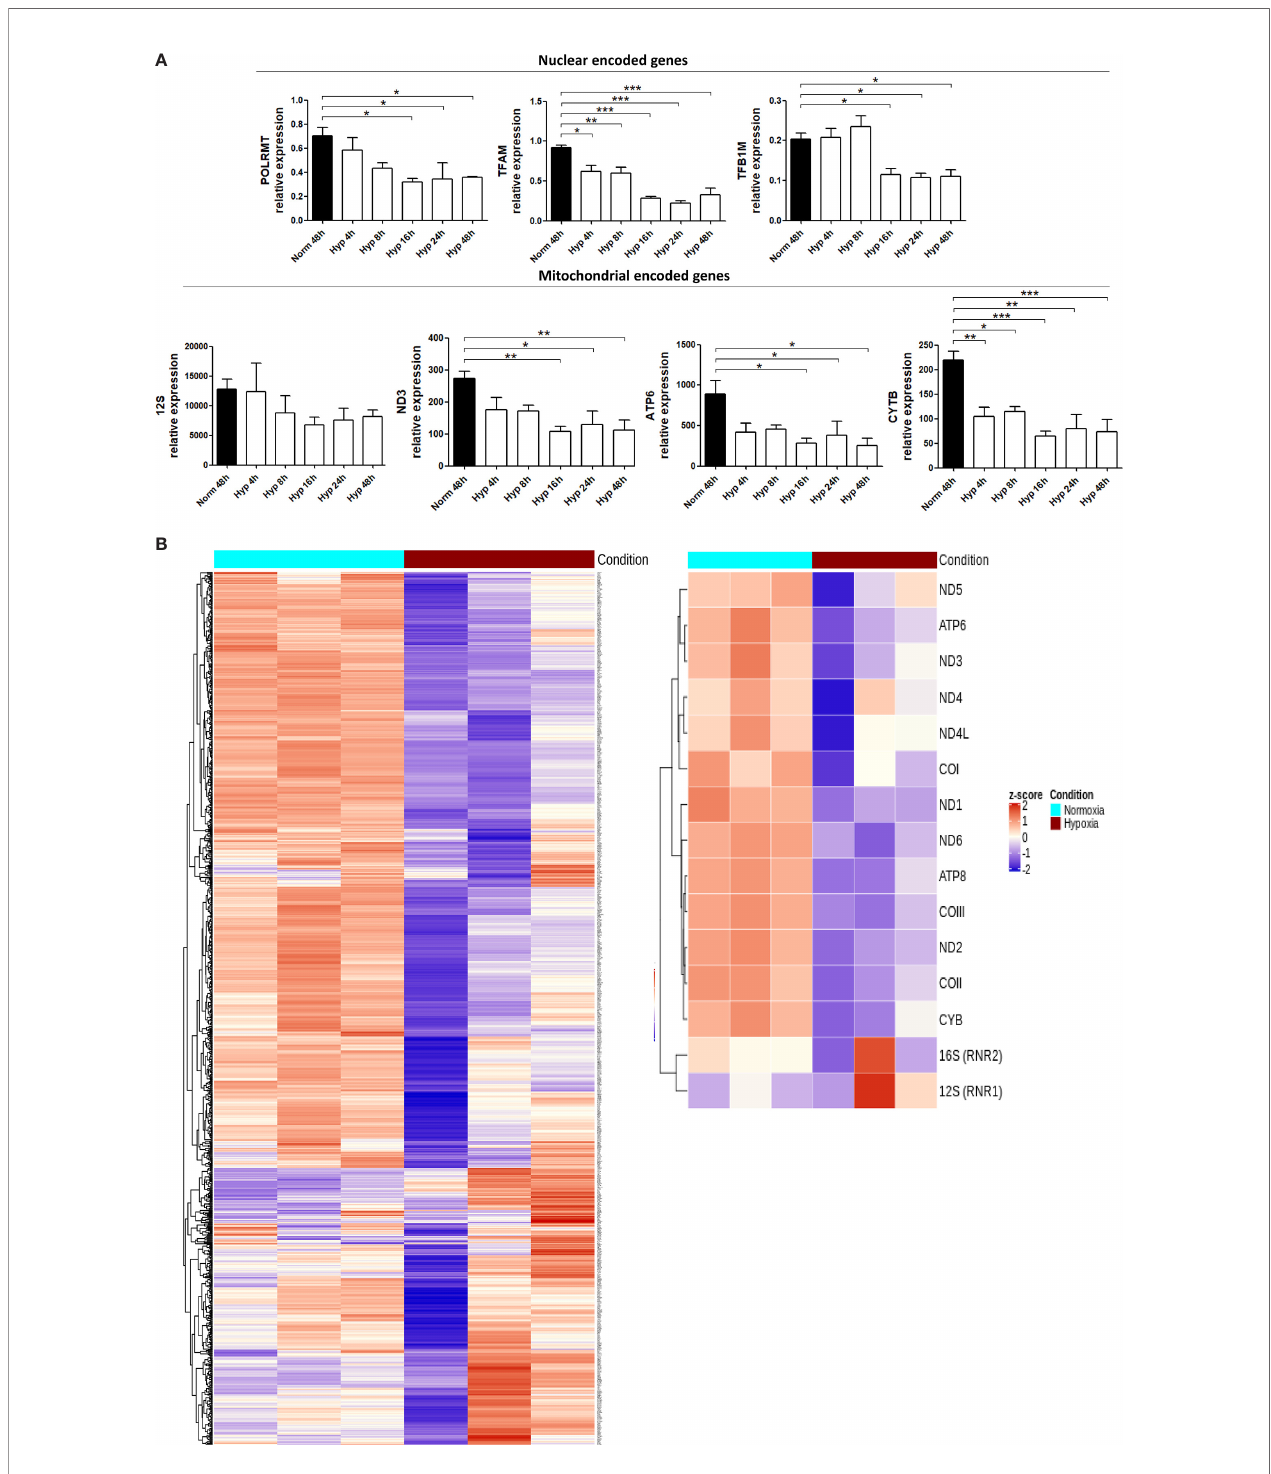
FIGURE 5 | Hypoxia downregulates the expression of mitochondrial genes. (A) RNA expression of mitochondrial encoded genes ( 12S, ND3, ATP6, CYTB ) or nuclear encoded genes involved in mitochondrial function ( POLRMT, TFAM, TFB1M ) in MCF7 cells cultured in normoxia or 0.1% hypoxia for 4h, 8h, 16h, 24h and 48h was evaluated by qPCR (n=3). (B) Heatmap showing expression of mitochondrial encoded genes (right panel) or 1158 nuclear encoded genes involved in mitochondrial function (left panel, from MitoCarta 2.0) in MCF7 cells cultured in normoxia or 0.1% hypoxia for 48h (n=3) from RNAseq experiment described in Materials section. Number of replicates indicate biological replicates and data is shown as mean ± SEM. *p < 0.05, **p < 0.01, ***p <